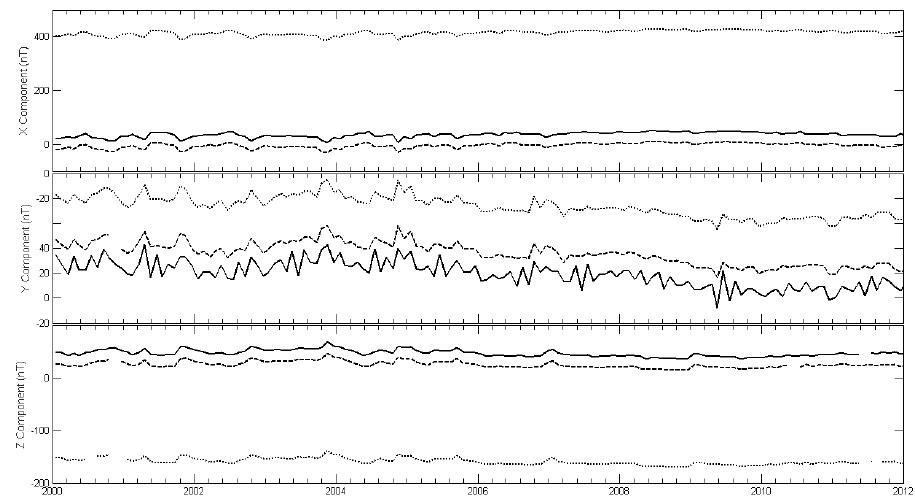
Figure 4. Differences between monthly mean values observed at WIK observatory and respective values predicted by EMM2015 model (dashed line), POMME-9 model (solid line) and CM5 model (dotted